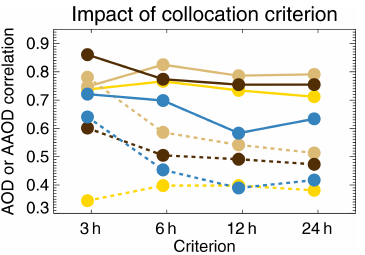
Figure 2. Correlation of satellite AOD (solid) and AAOD (dashed) with AERONET Inversion L2.0 data, as a function of a tempo- ral collocation criterion. Colours indicate the satellite product (see also Fig. 1). Satellite products were individually collocated with